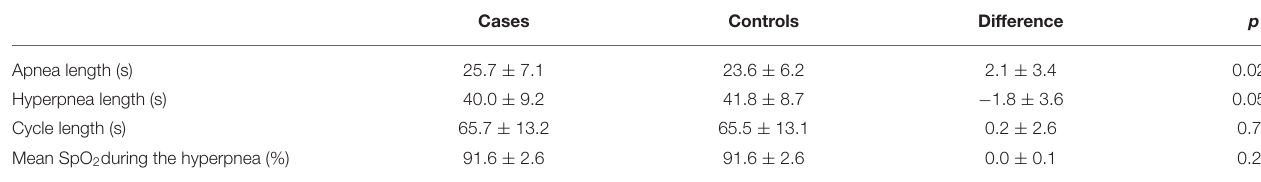
TABLE 2 | Change in apnea length between apneas preceded by a hyperpnea with arousal (cases) and those preceded by a hyperpnea without arousal (controls).